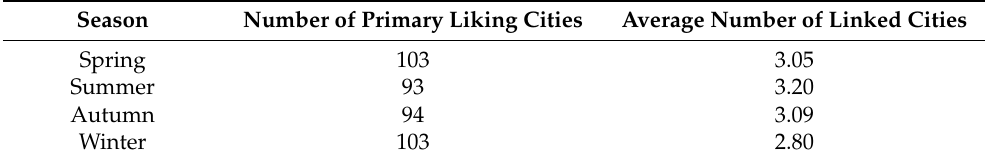
Table 3. Statistical characteristics of the primary linking